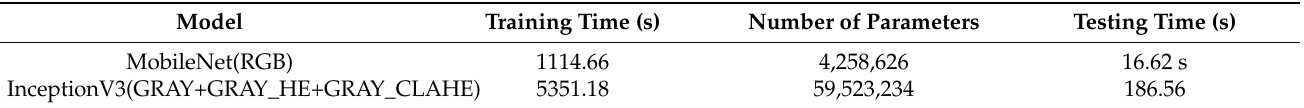
Table 9. The number of parameters with training and testing time of the models.